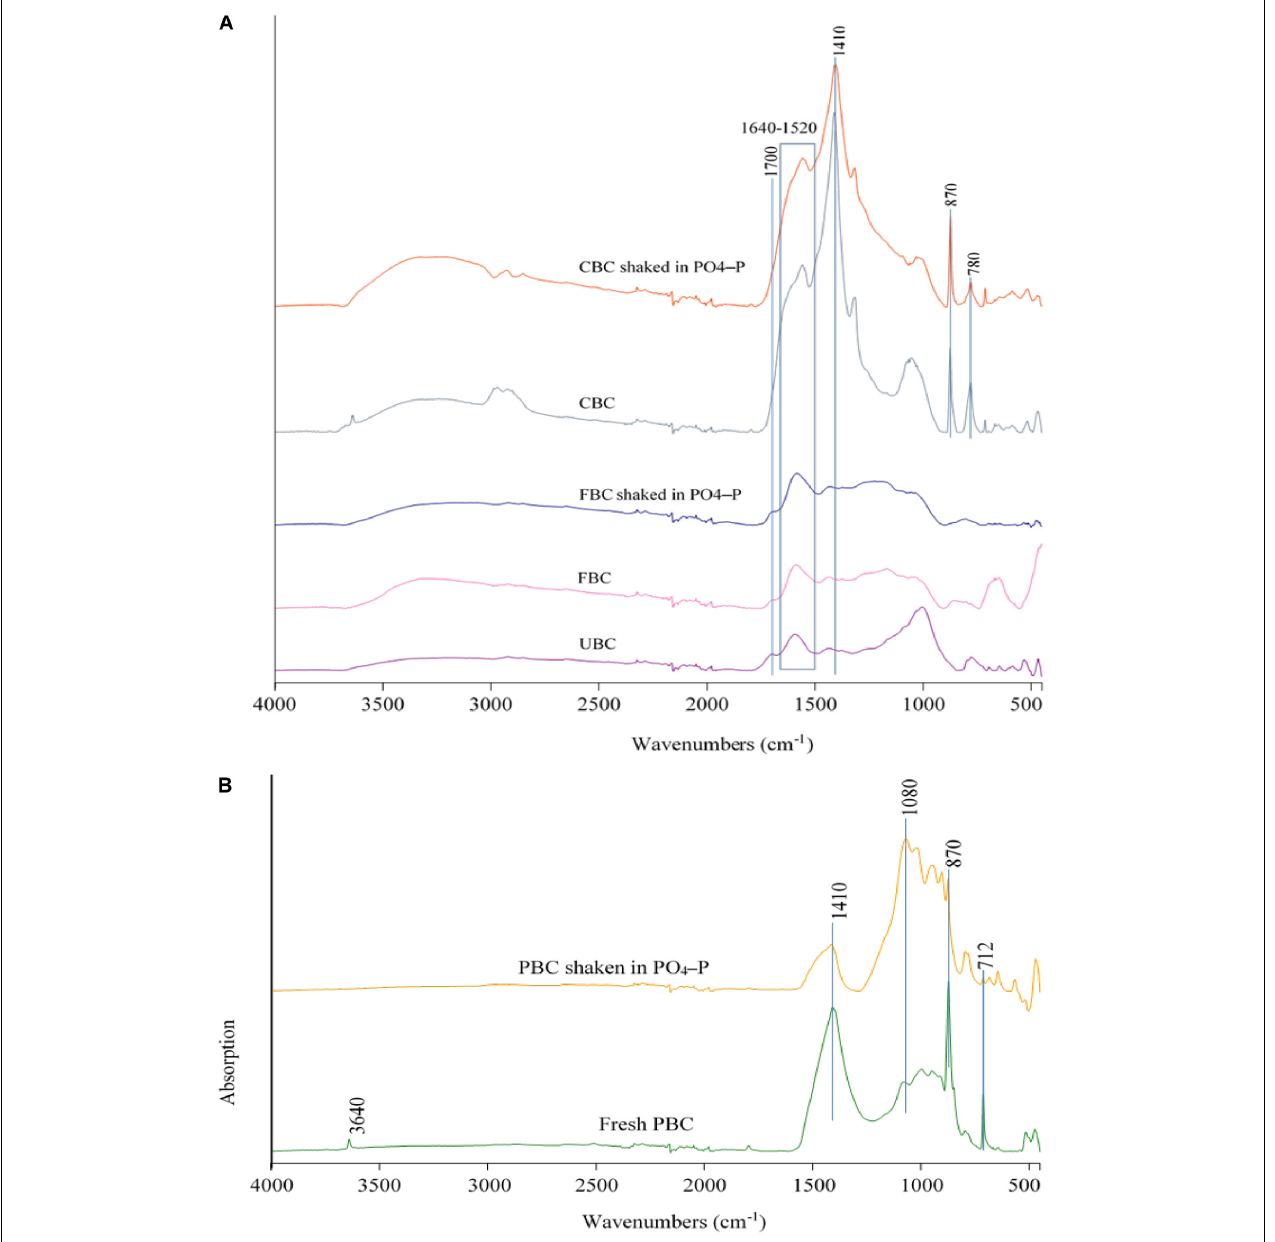
FIGURE 2 | Fourier transform infrared (FTIR) spectra of: (A) unimpregnated biochar (UBC, purple), biochar impregnated with calcium oxide (CBC, orange), and biochar impregnated with ferric chloride (FBC, blue); and (B) biochar mixed with Polonite (PBC), fresh or shaken in PO 4 -P solution.